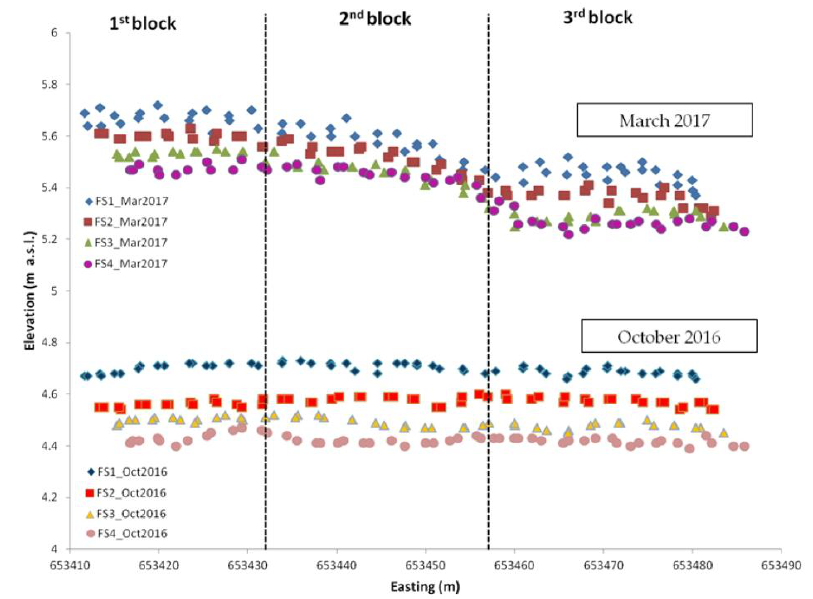
Figure 7. Trend of the four flat strips for October 2016 and March 2017, before and after the extreme events, respectively.